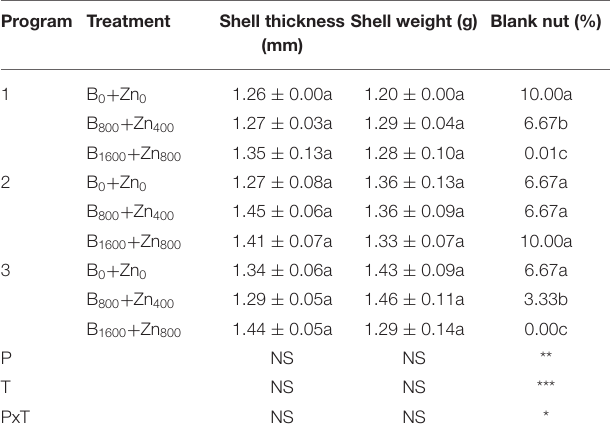
Values represent the mean (n = 3) ± SE. Different letters indicate statistically significant differences (P ≤ 0.05) among treatments within each spray program. Two-way ANOVA results are shown (NS, not significant, P > 0.05; * P < 0.05; ** P < 0.01; *** P < 0.001).